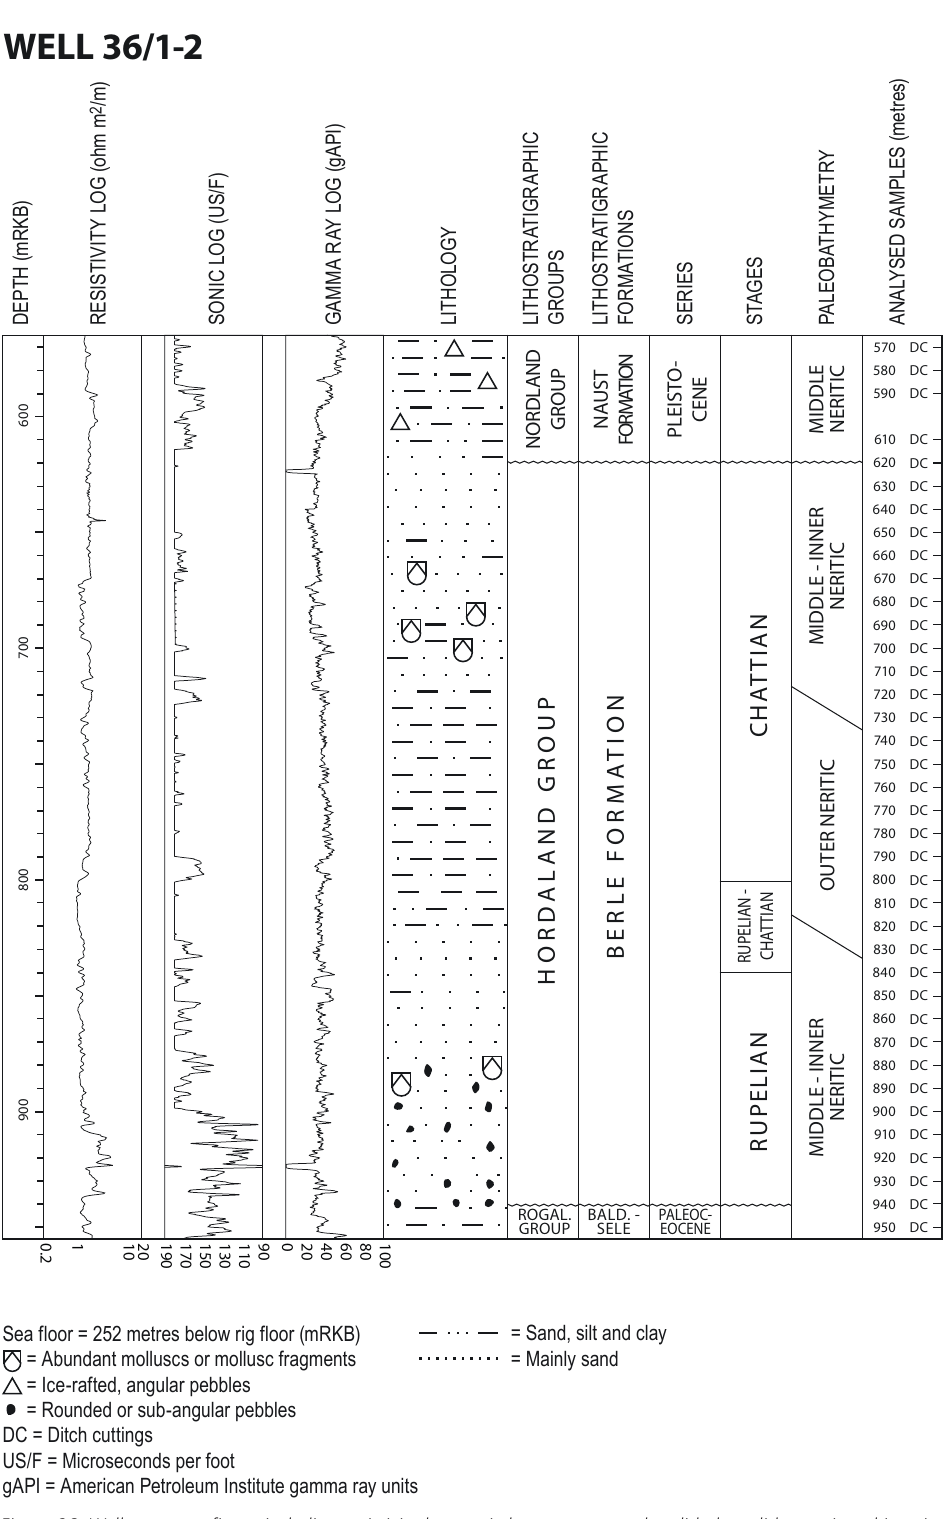
Figure 36. Well summary figure including resistivity log, sonic log, gamma-ray log, lithology, lithostratigraphic units, series, stages, paleobathymetry and analysed samples for the investigated sequence in well 36/1–2 (Paleocene/Eocene to Pleistocene) including the well type section for the Berle Formation (modified after Eidvin et al.,